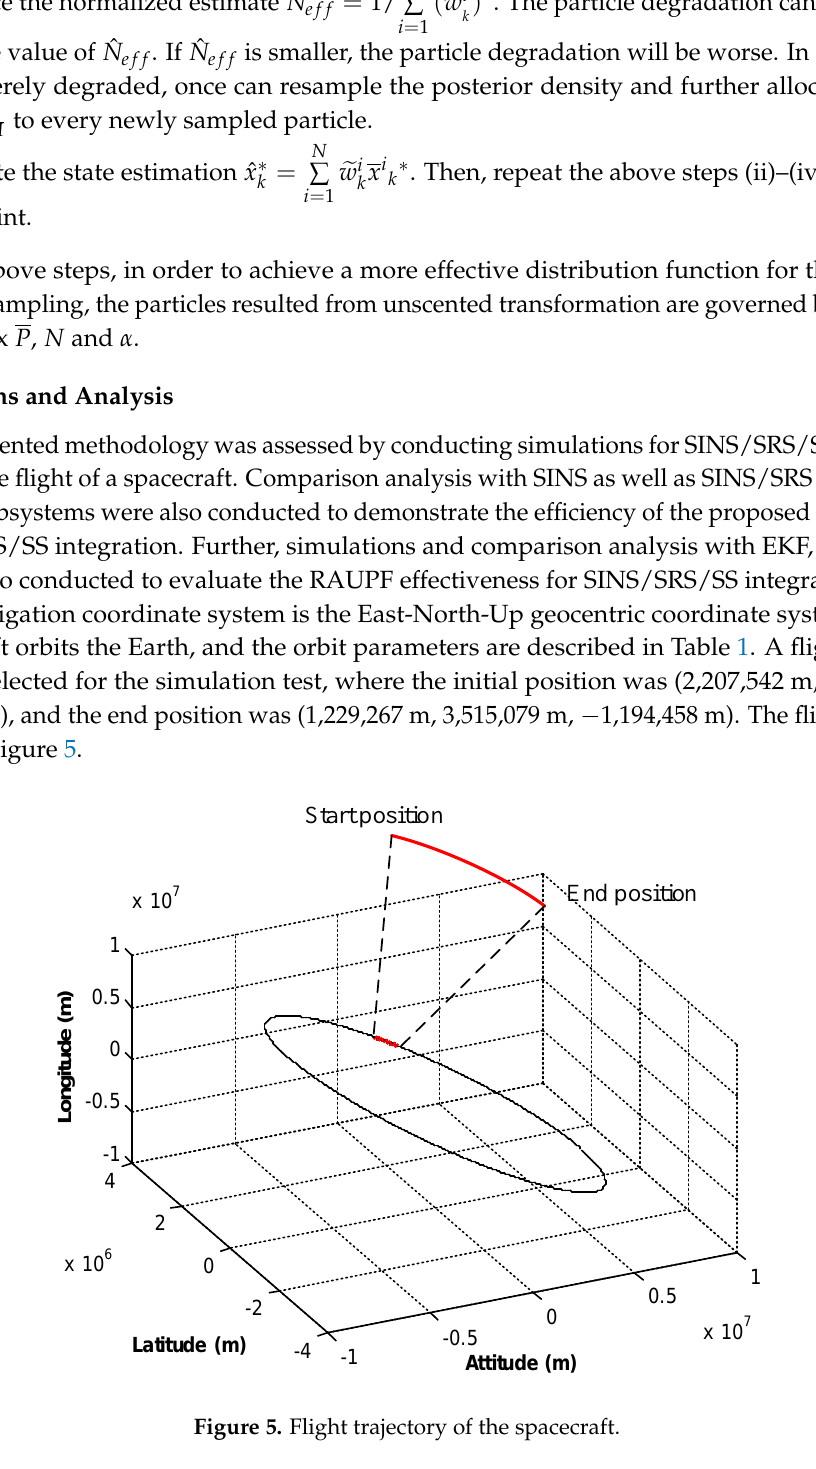
Figure 5. Flight trajectory of the spacecraft.